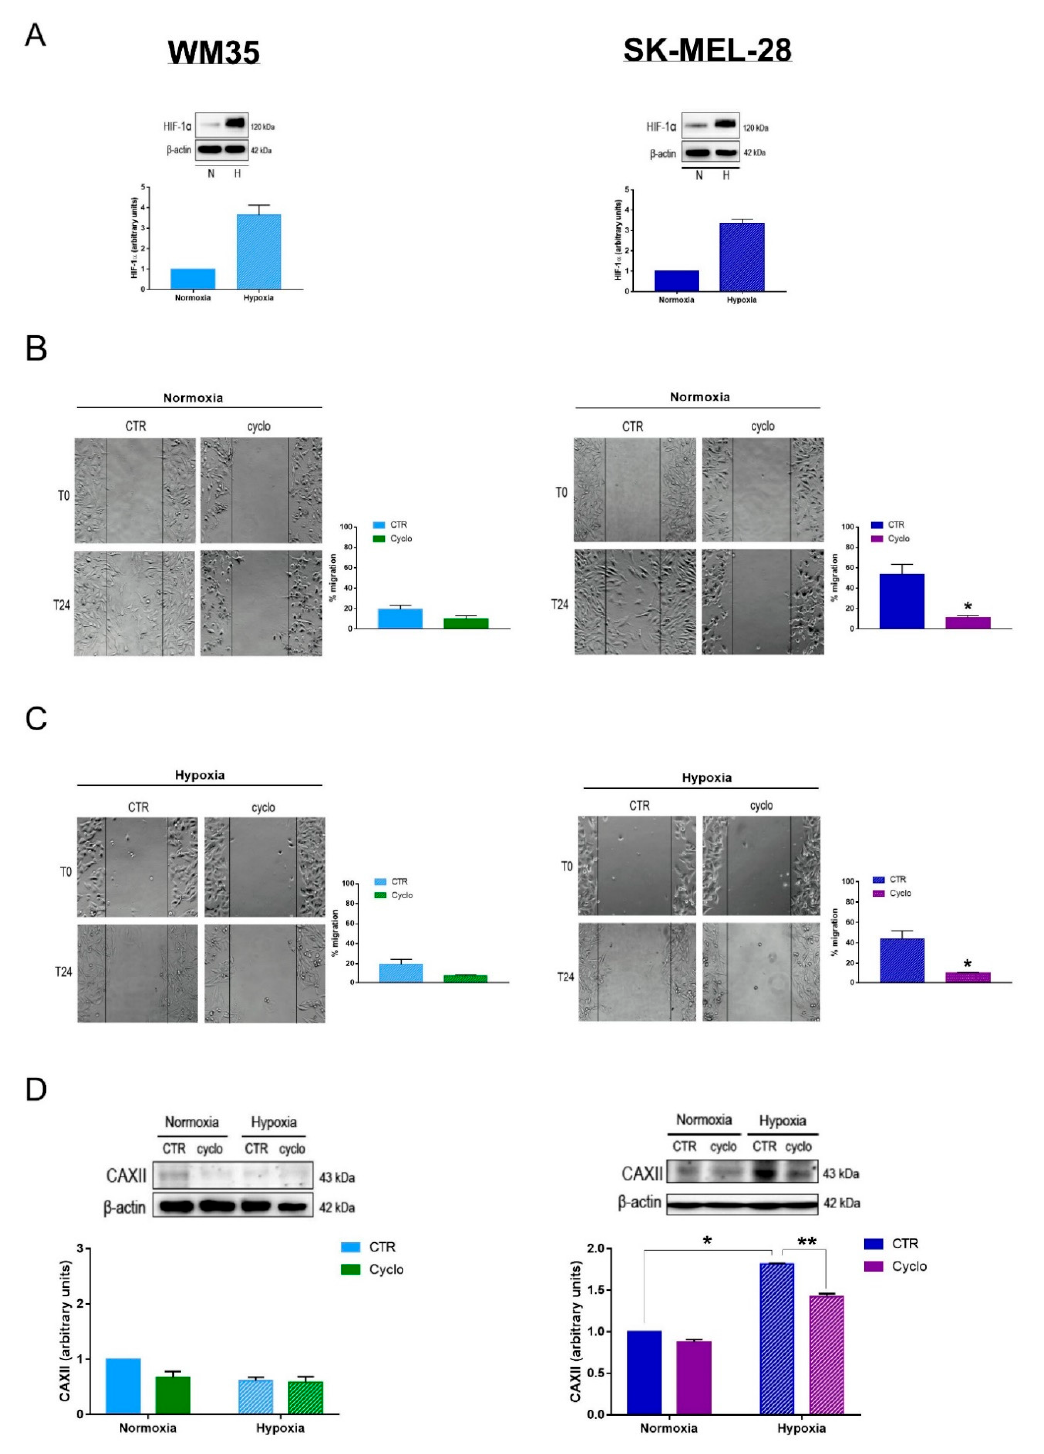
Figure 1. Inhibition of the Hedgehog pathway affects melanoma cell migration and CAXII protein expression. ( A ) HIF-1 α protein expression in WM35 and SK-MEL-28 after 24 h exposure to normoxia or hypoxia. Blots are representations of the means of three independent experiments and β -actin was used as loading control. ( B ) Representative image of WM35 and SK-MEL-28 scratch assay after 24 h treatment with 20 µM cyclopamine (cyclo) under normoxia. Phase contrast microscopy images were taken with Olympus IX81 at a 10X magnification. Quantifications represent the means and standard errors of the mean of three independent